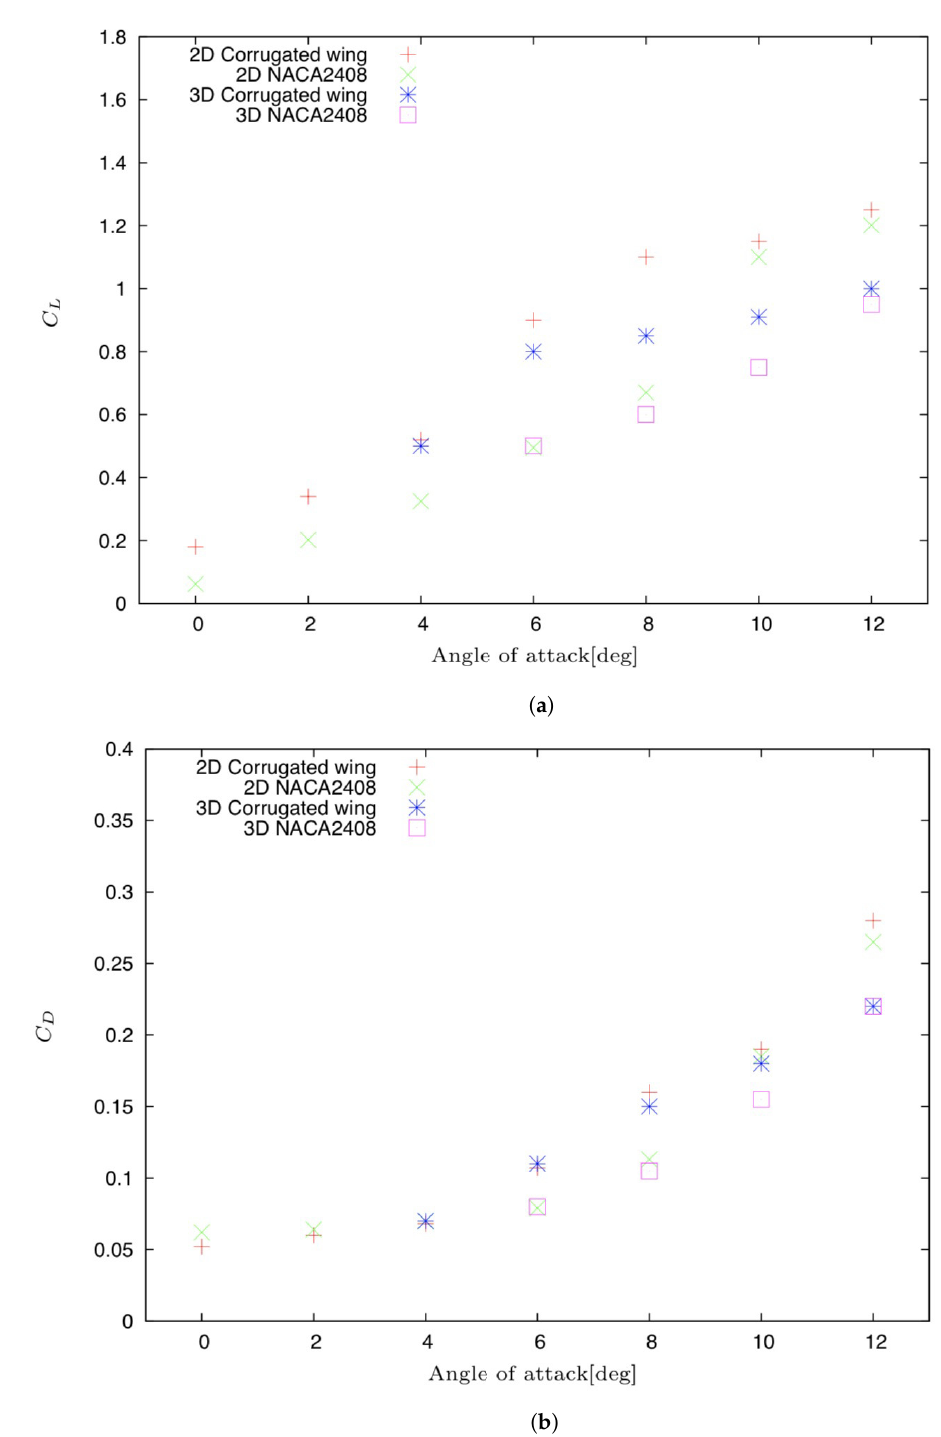
Figure 16. The averaged lift and drag coefficient of 2D and 3D calculations for the corrugated airfoil and NACA2408 airfoil at Re = 4000 with varying angle of attack: ( a ) lift coefficient; and ( b ) drag